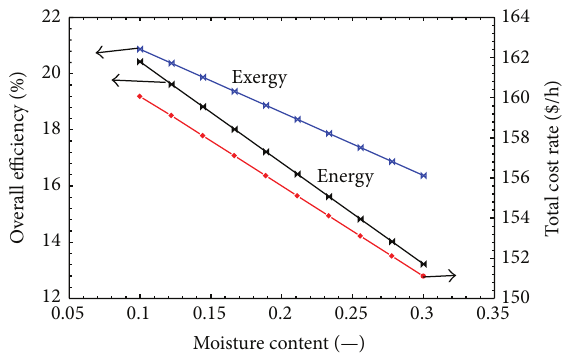
Figure 10: The impact of the biomass moisture content on the objective functions.